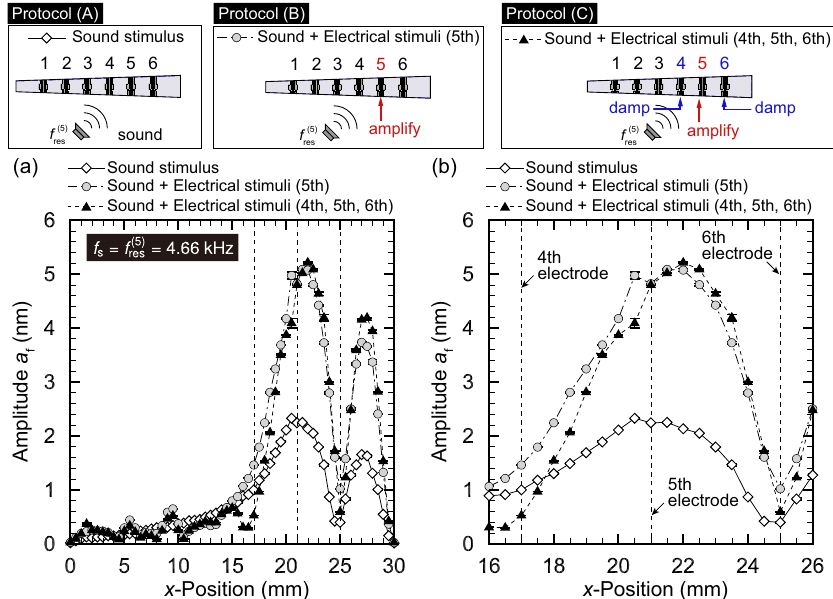
Figure 6. Vibration amplitude distribution for protocol (A): only sinusoidal sound stimuli with f s = 4.66 kHz; protocol (B): sound and electrical stimuli applied to the fifth electrode; and protocol (C): sound and electrical stimuli applied to the fourth to sixth electrodes. ( a ) Entire view and ( b ) magnified version near x ( 5 ) . Protocol (B) succeeded in amplifying a f at resonant position x ( 5 ) = 21 mm. In addition to the amplification in Protocol (B), Protocol (C) damped a f of neighboring positions x ( 4 ) and x ( 6 ) , where there were damping controls with opposite phases for the fourth and sixth